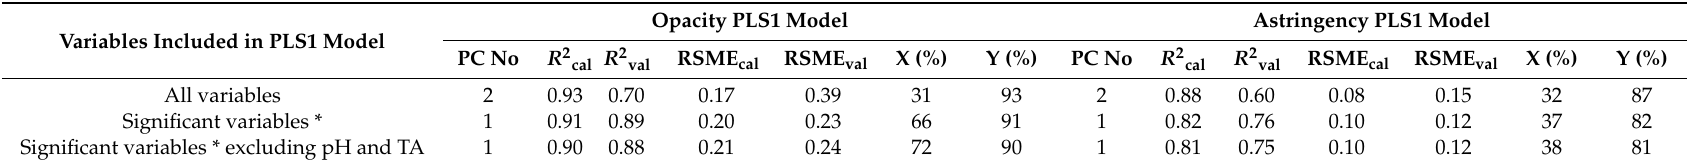
Table 6. Partial least squares (PLS1) regression analysis of the wine sensory attributes opacity and astringency (Y) showing the total principal component (PC) number in the model, R -squared values for calibration (cal) and validation (val), root mean squared error of prediction (RMSE) and the explained variance (%) for all compositional X variables, and sub-sets of significant X